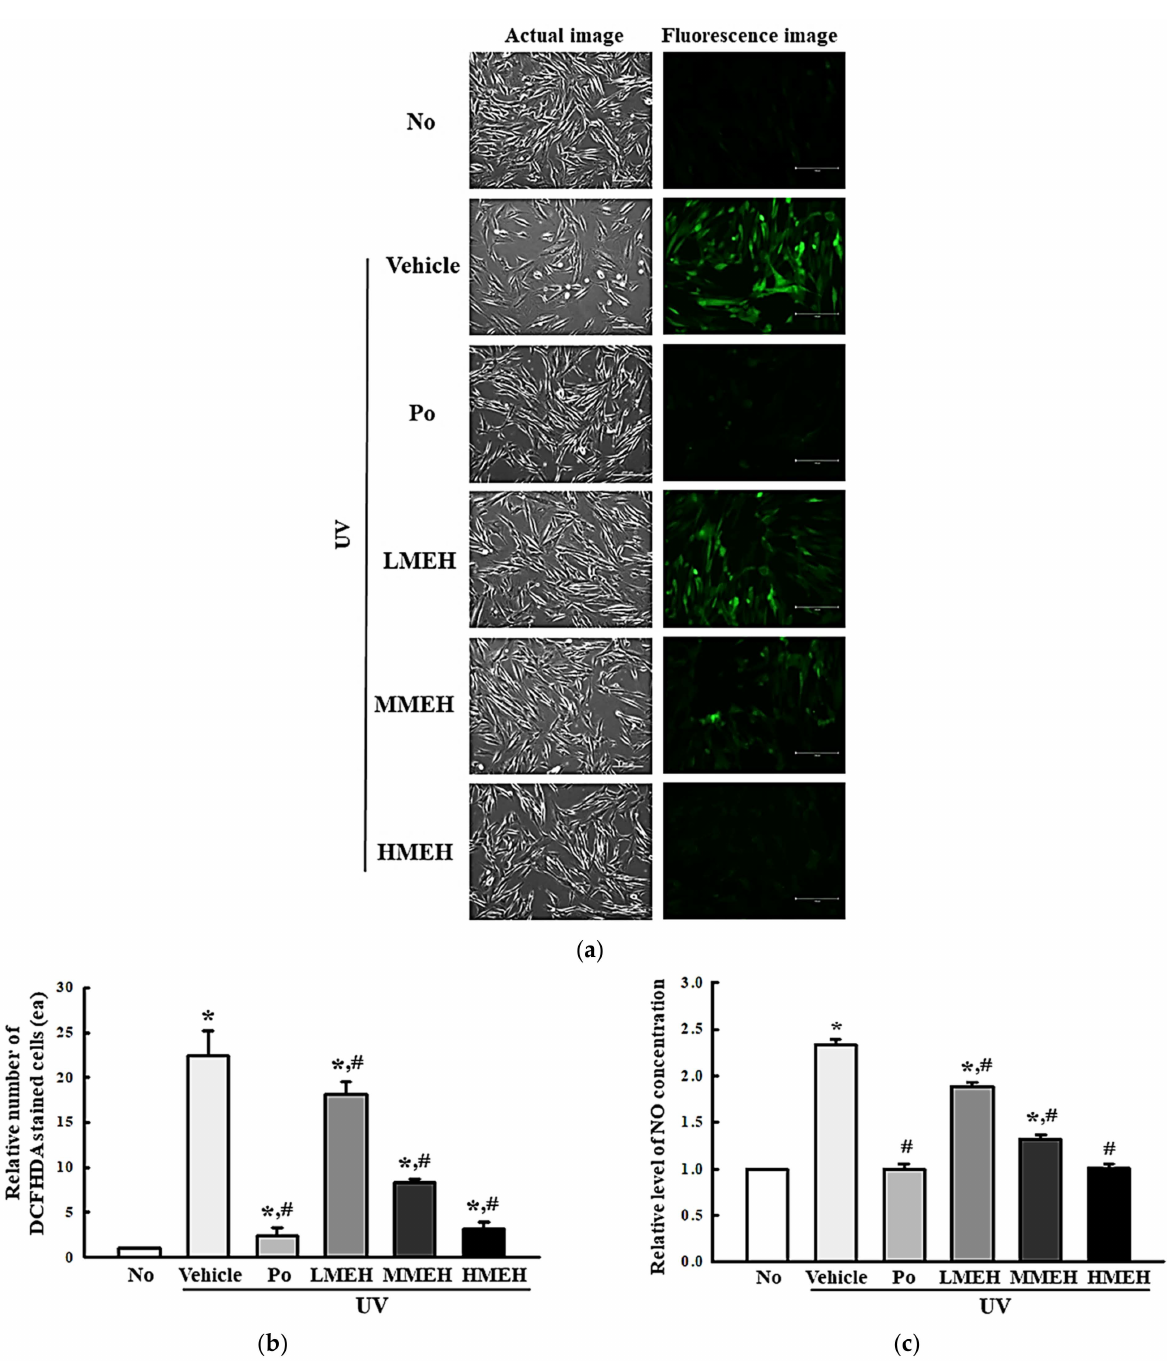
Figure 2. Detection of ROS and NO in normal human dermal fibroblasts. ( a , b ) Determination of intracellular ROS production. The cells were stained with DCFH-DA, and green fluorescence-stained cells were observed using a fluorescent microscope at 200 × magnification; ( c ) Determination of the NO concentration. Three wells per group were used for DCFH-DA staining and NO assay, and the assays were repeated for three times. Data represent the mean ± SD of triplicates. *, p < 0.05 relative to the untreated group. #, p < 0.05 compared to the UV + Vehicle group. Abbreviations: ROS, reactive oxygen species; NO, Nitric oxide; Po, Positive control; DCFH-DA, 2 (cid:48) ,7 (cid:48) -Dichlorofluorescin diacetate; MEH, Methanol extract of Hygrophila erecta (Brum. F.)